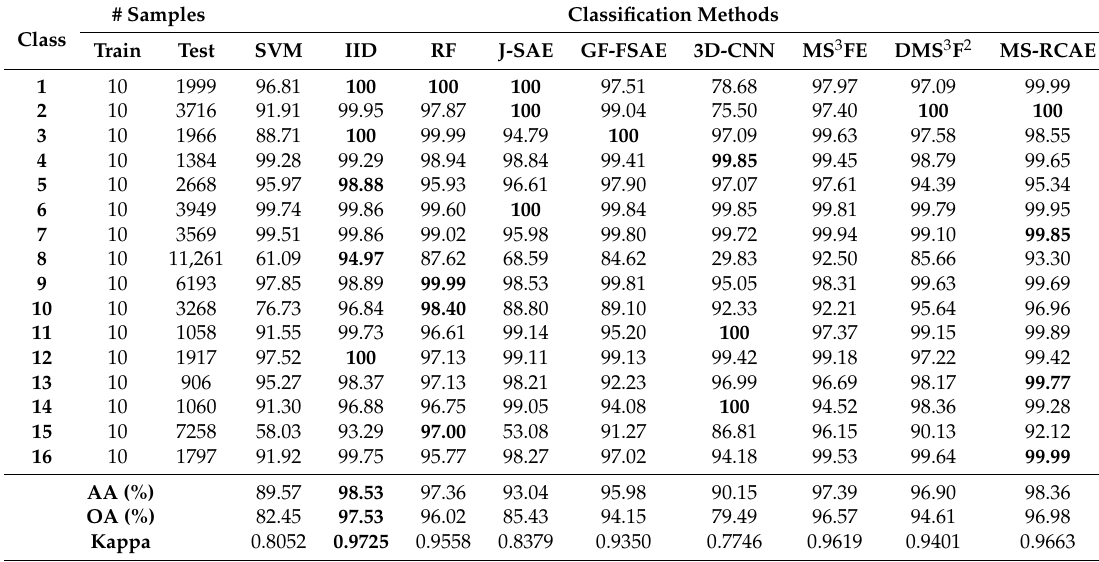
Table 3. Classification accuracies of the Salinas dataset obtained by each comparison methods. The best results are highlighted in bold font.